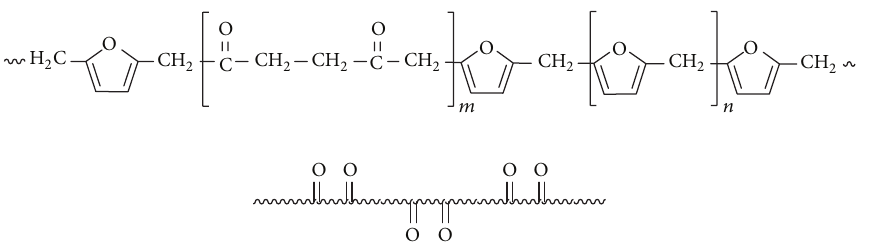
Figure 2: Structure of polyfurfuryl alcohol (PFA) with opened furan ring